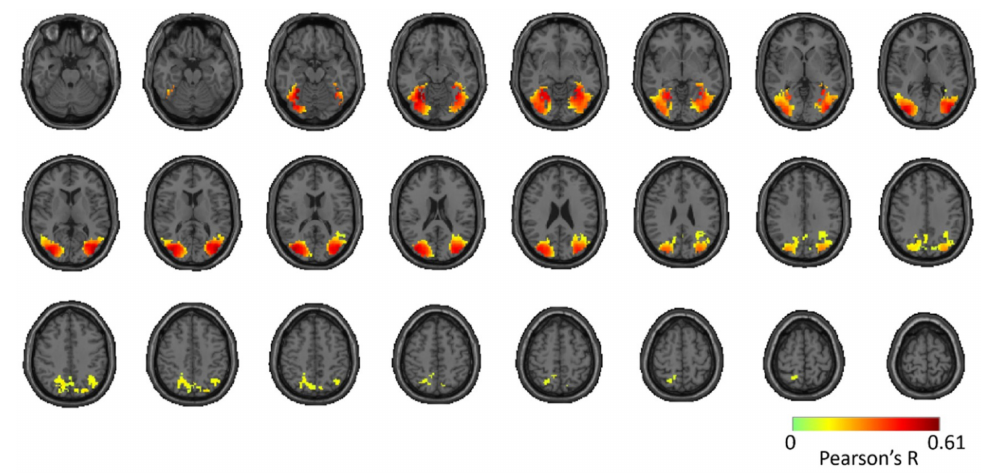
Figure 5. Reliability map of MEG-fMRI fusion time courses for Twin set 1 and Twin set 2. The figure shows significant clusters projected onto a standard T1 MNI brain. Significant correlations are determined with permutation tests and multiple comparison corrections using cluster correction method (n = 15; cluster-definition threshold of P < 0.01, and cluster size threshold of P < 0.01).